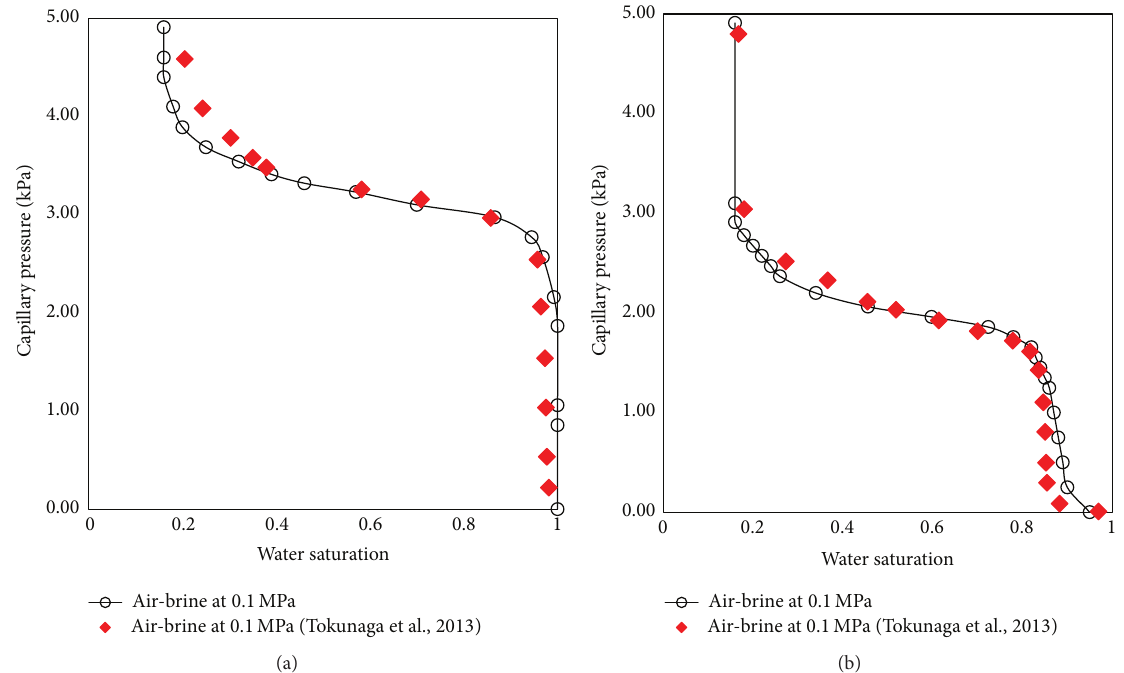
Figure 2: Capillary pressure-water saturation curve using the air-brine at 0.1MPa pressure, 1 M NaCl. (a) Drainage and (b) imbibition. 0.001.002.003.004.005.00